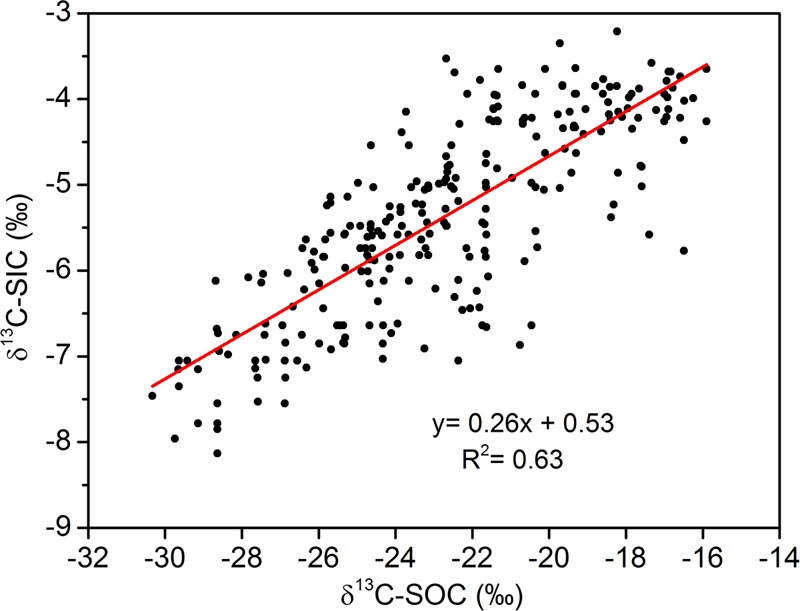
Relationships of soil inorganic δ13C value (δ13C-SIC) with soil organic δ13C value (δ13C-SOC) (using all 260 samples within 0–100 cm depth from four sample plots). Significance of the linear regression was considered as P < 0.01.